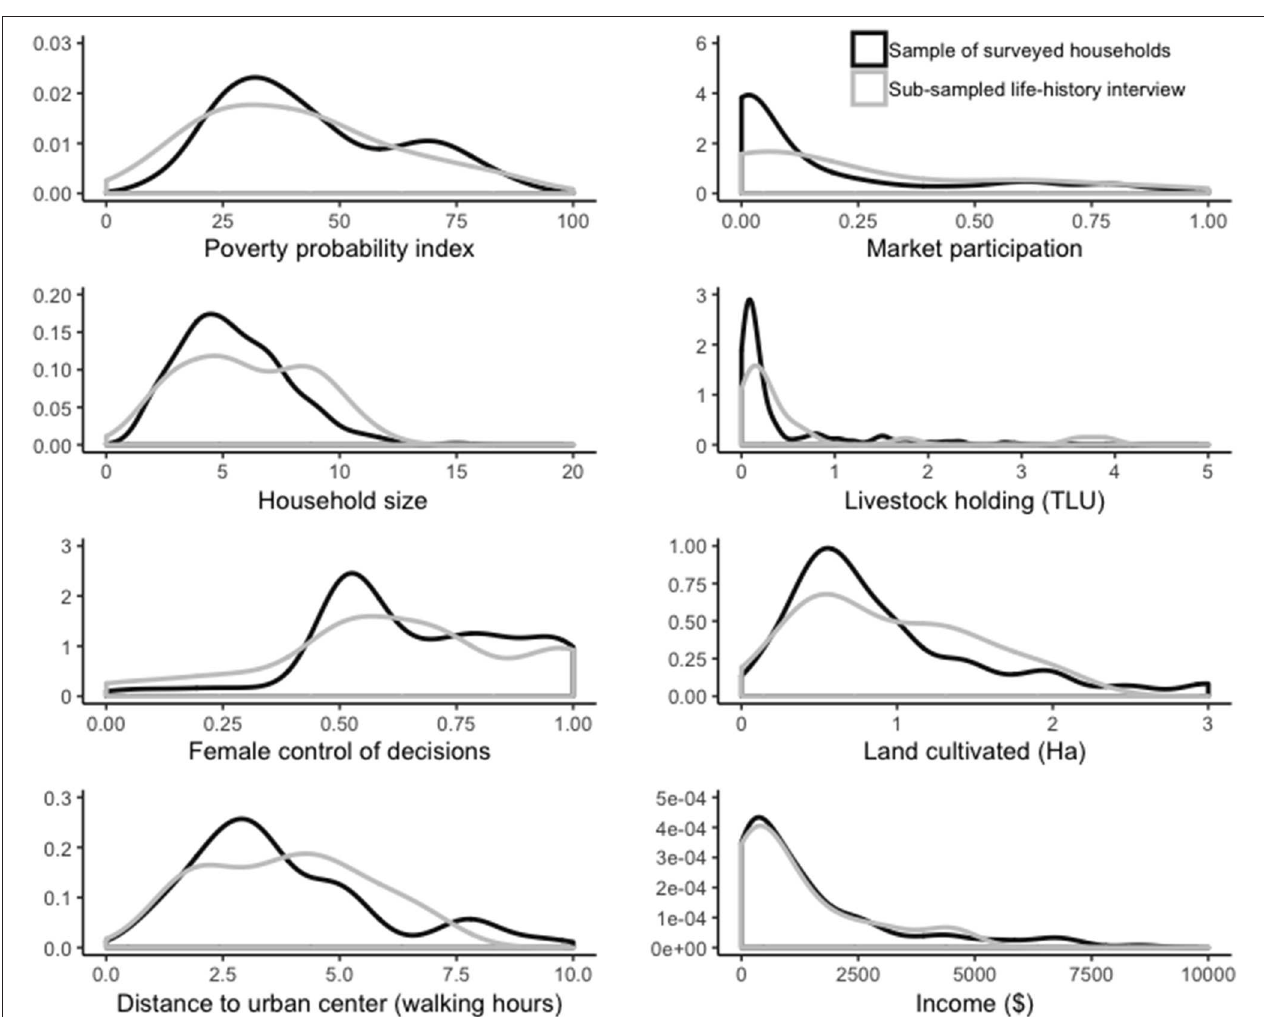
FIGURE 2 | The probability density function (PDF) of socio-economic indicator values derived from the Rural Household Multi-Indicator Survey (RHoMIS). Black and gray illustrate the PDF for the total survey population, and the sub-sample of households visited for follow up life-history interviews, respectively.